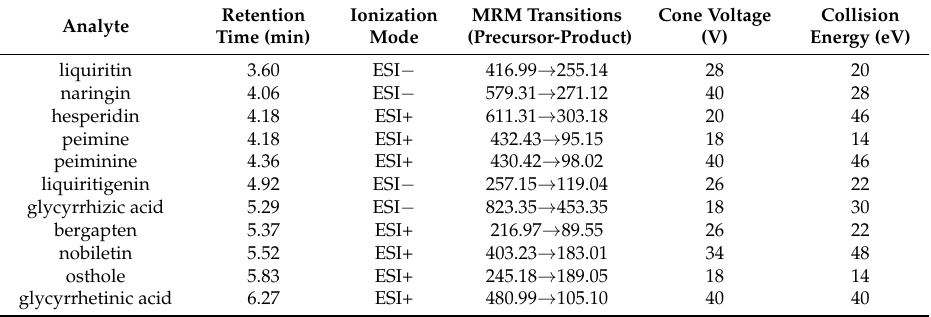
Table 10. Precursor/production pairs and parameters for MRM of compounds 1 – 11 used in this study. Retention Ionization MRM Transitions Analyte Time (min) Mode (Precursor-Product)